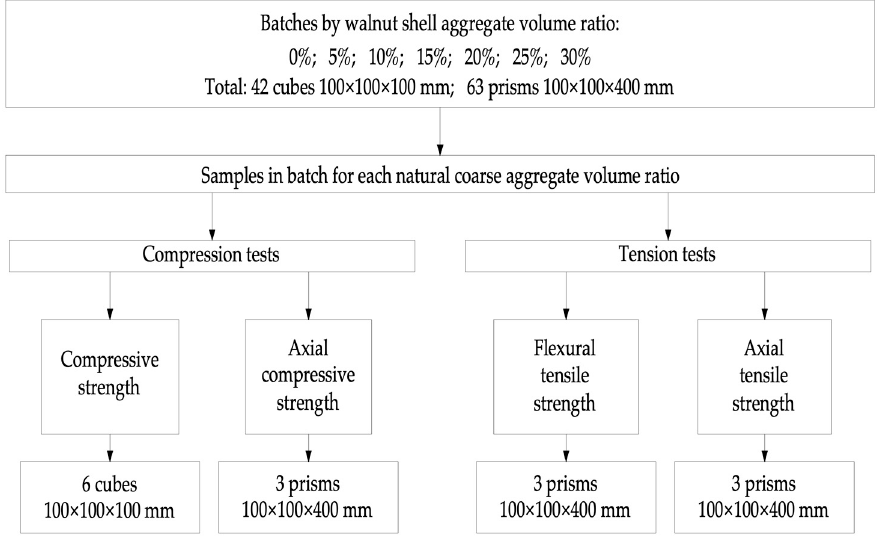
Figure 4. Program for testing concrete samples.